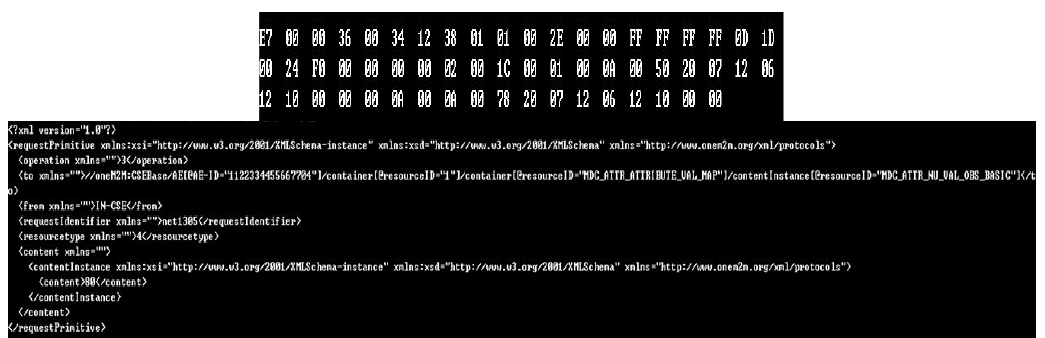
Figure 18. Resource tree created by the IoT server (IN-CSE) after the registration process.